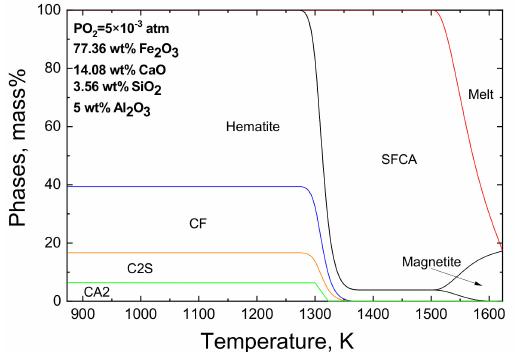
Figure 5. Calculated mineral composition of the sinter at oxygen partial pressure of 5 × 10 − 3 atm under various